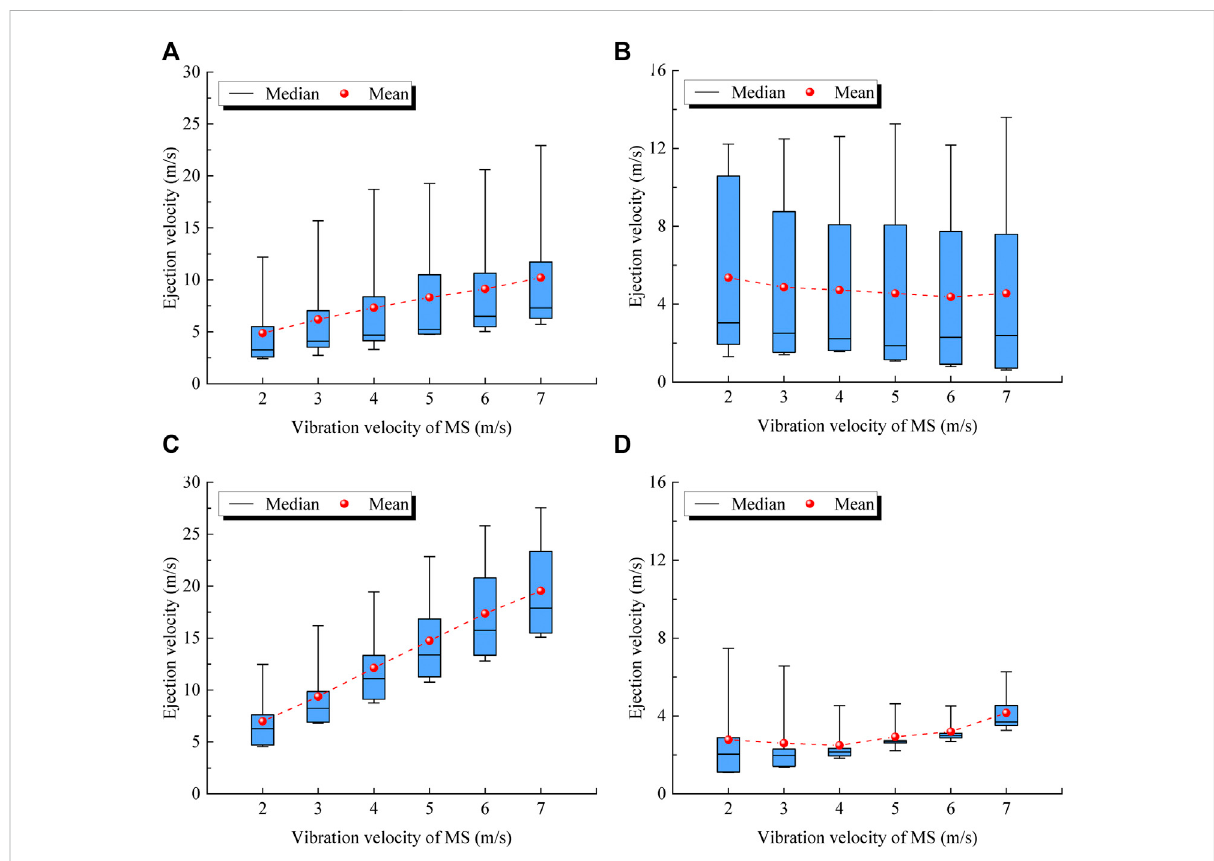
FIGURE 13 Ejection velocities around the headentry considering different vibration velocities: (A) at the top, (B) at the bottom, (C) at RSR, and (D) at WFR.